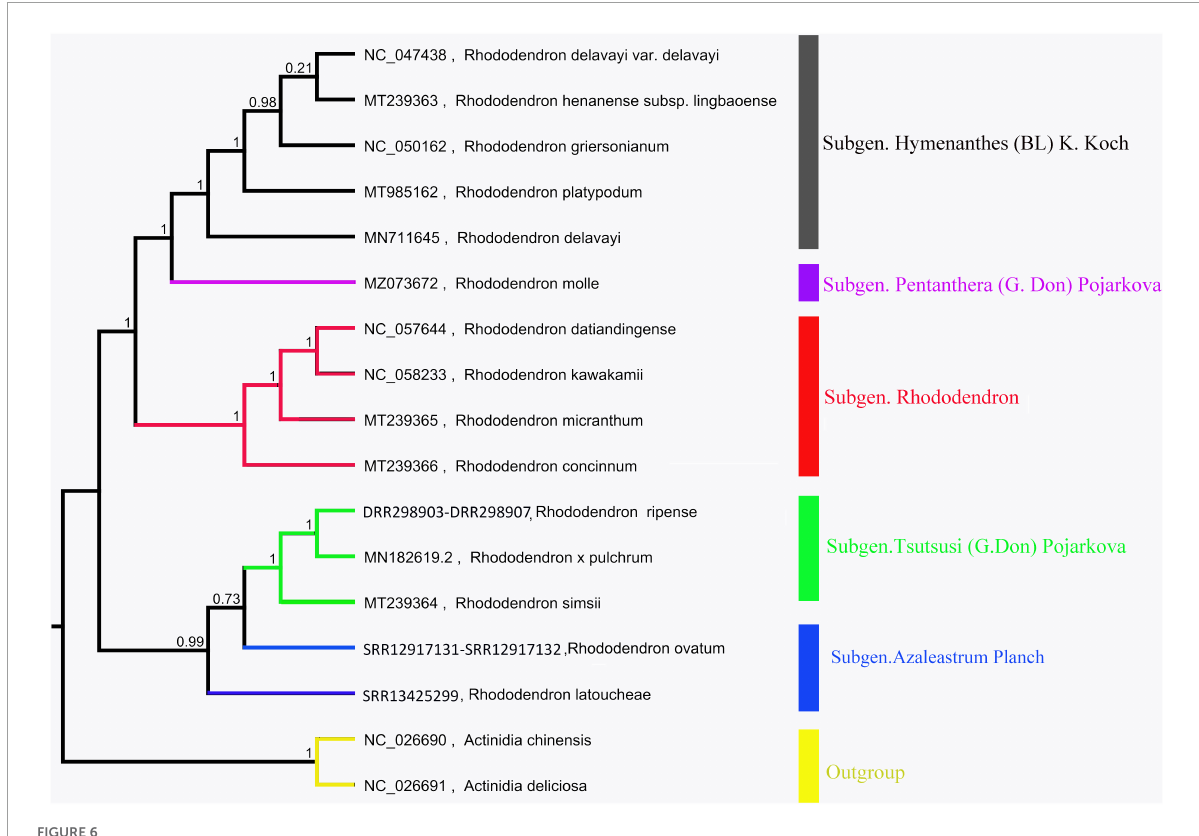
FIGURE6 Phylogenetic tree of Rhododendron species based on chloroplast genomes. Actinidia deliciosa and Actinidia chinensis were used as the